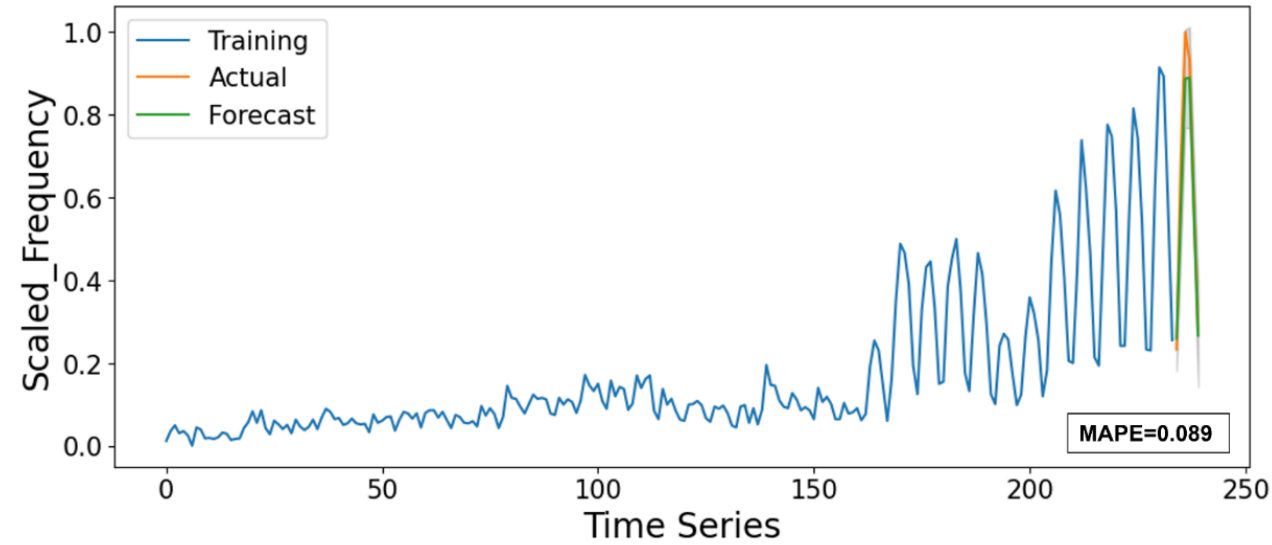
Figure 5. Prediction results of ARIMA (2,1,3) model (MAPE = 0.089). The blue line represents training data, and the orange and green lines represent actual and forecasted values, respectively.